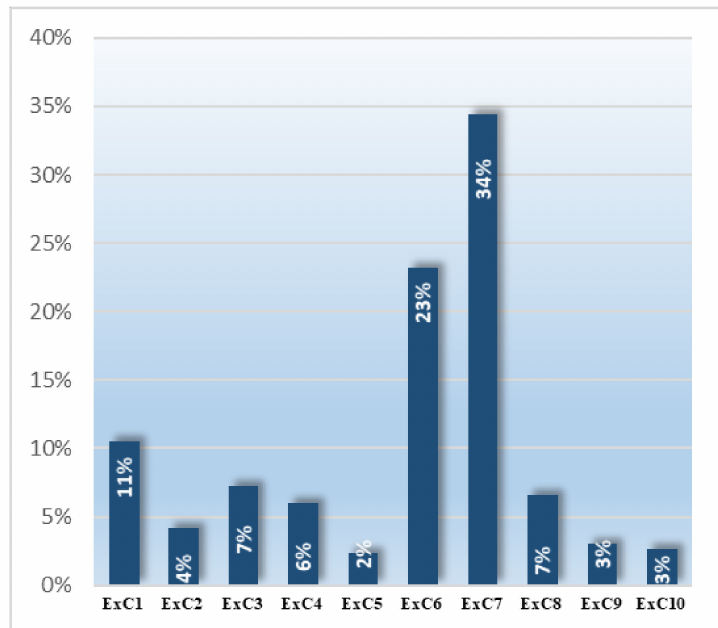
Figure 5. Percentage of papers excluded for each exclusion criterion.